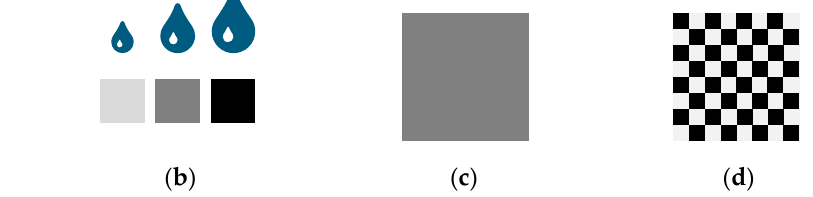
Figure 2. ( a ) Conventional droplet to pixel mapping with equal droplet sizes. ( b ) Grayscale printing with custom droplet size variation mapped to different shades of gray. ( c ) Grayscale image producing a single intermediate droplet size. ( d ) Dithered grayscale image containing only black and white pixels to simulate an intermediate droplet size not possible with the printhead or not covered using grayscale approach.